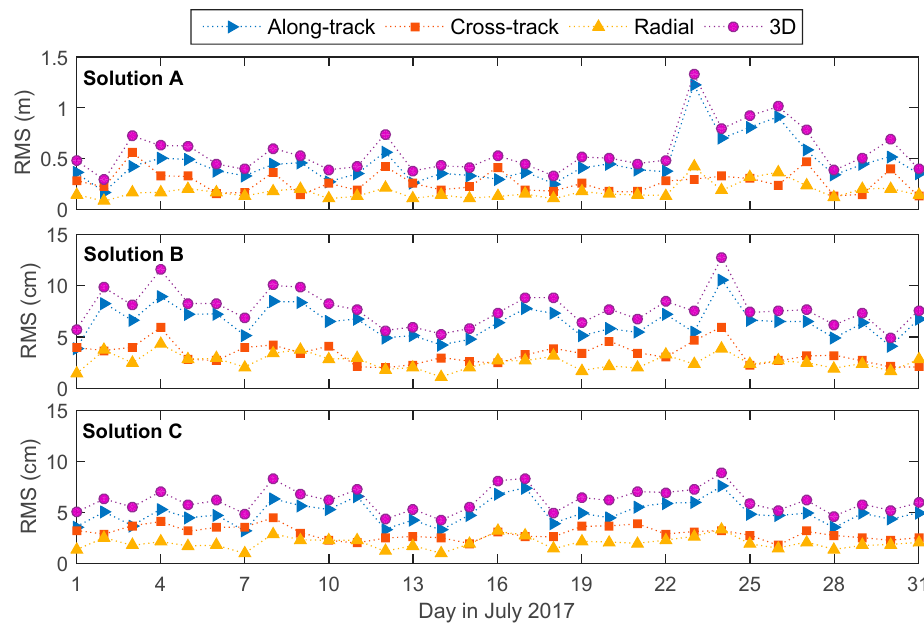
Figure 7. Daily RMS series of orbit differences in along-track, cross track, radial, and 3D between BDS-derived and GPS-derived FY-3C orbit, the top, middle, and bottom subgraphs give the solution A, B, and C, respectively.